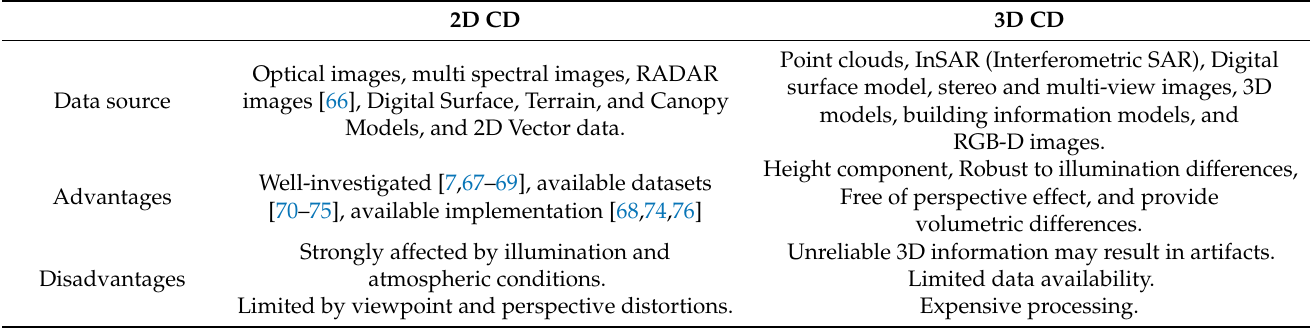
Table 1. Summary of main differences between 2D and 3D CD specificities